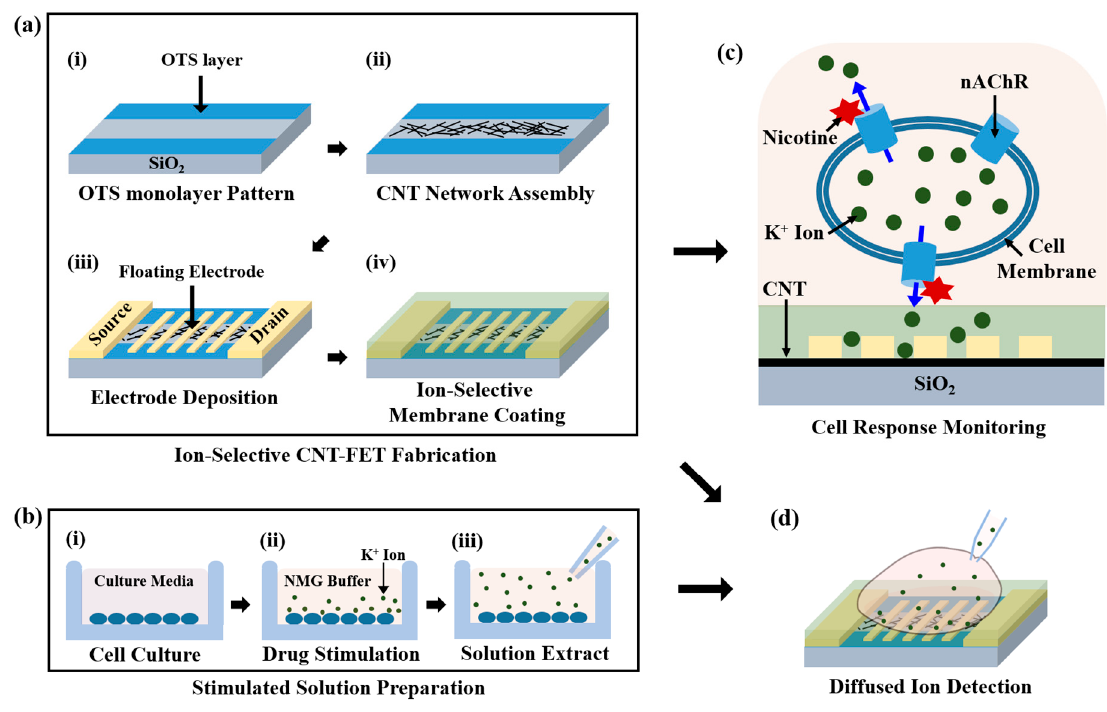
Figure 1. Schematic diagram depicting the procedures to prepare sensors and measure the potassium ions released from live cells. ( a ) Fabrication of an ion-selective carbon nanotube field-effect transistor (CNT-FET): (i) Patterning of octadecyltrichlorosilane (OTS) layers; (ii) specific adhesion of CNTs; (iii) deposition of floating electrodes on the CNT channel; (iv) coating of ion-selective membrane. ( b ) Cell preparation and stimulation: (i) culturing PC12 cells in an RPMI 1640 medium; (ii) stimulation of cells after media change; (iii) extraction of stimulated solution using a micropipette. ( c ) Direct monitoring of individual cell responses to nicotine using an ion-selective sensor. ( d ) Detection of potassium ion in the extracted solution using the sensor. The above drawing is not to scale.